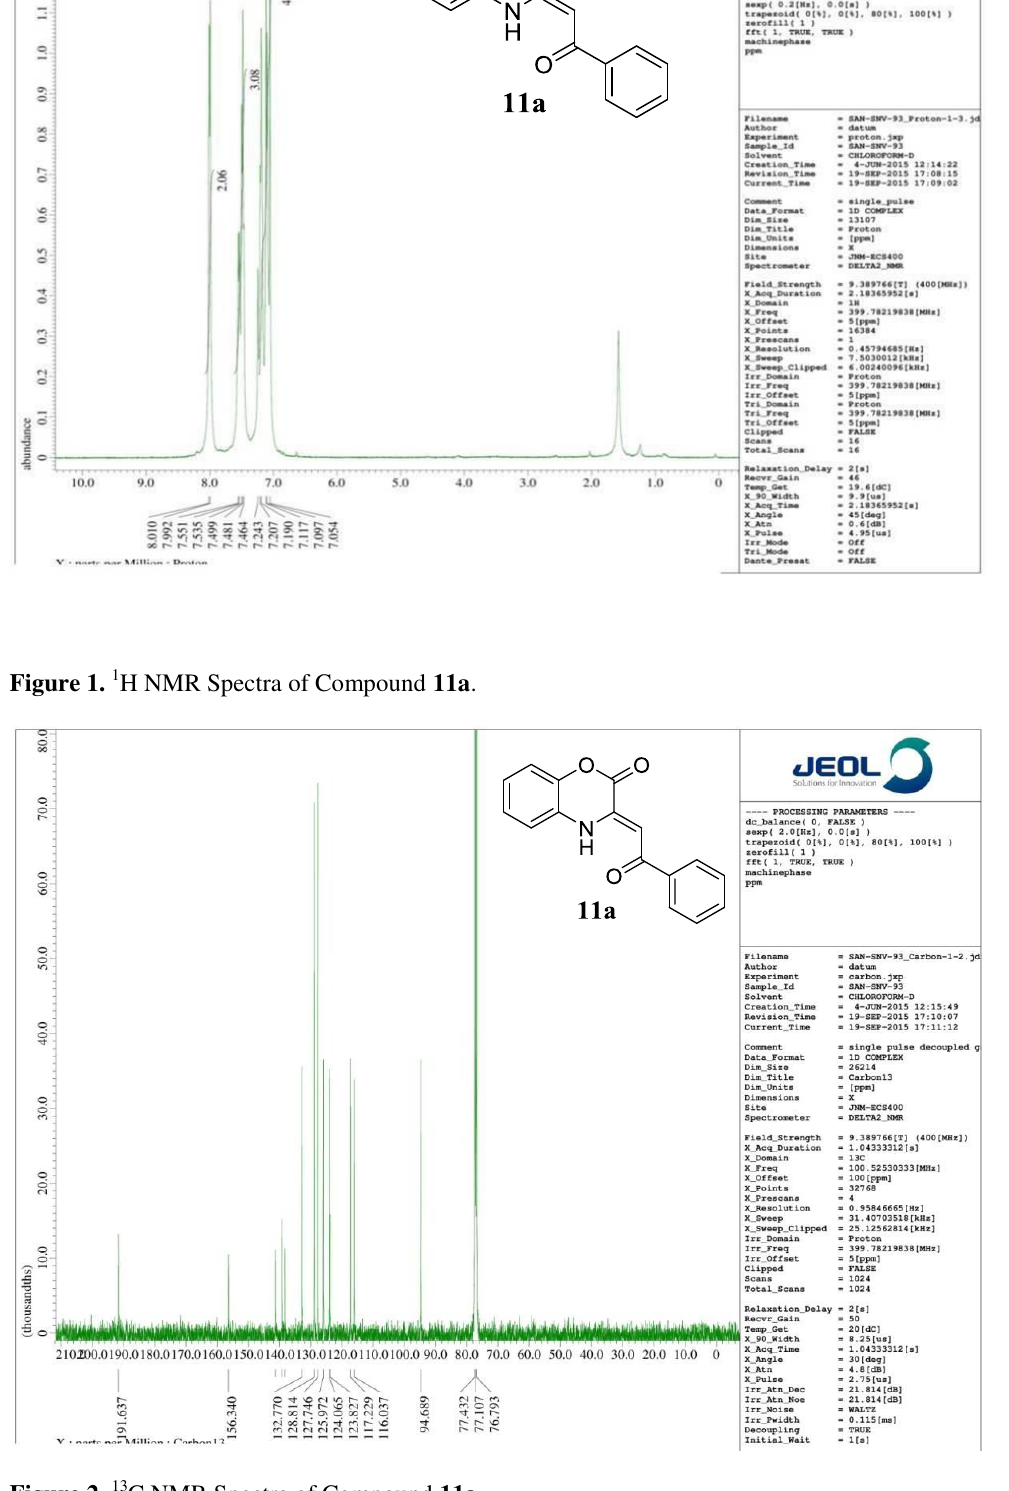
Figure 2. 13 C NMR Spectra of Compound 11a